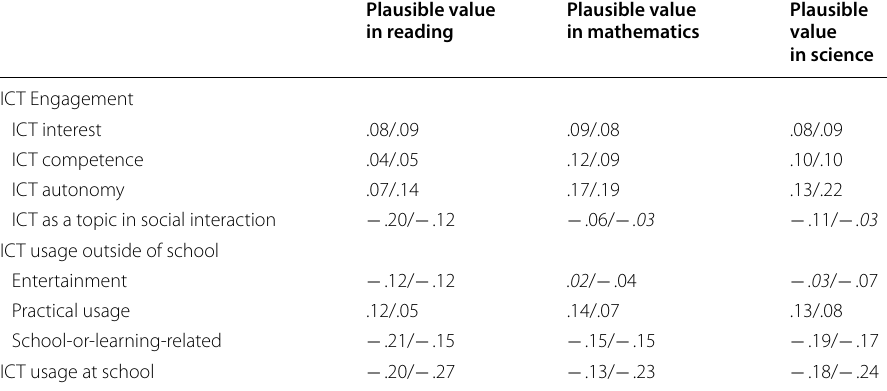
Table 6 Correlations between ICT Engagement scales, ICT Usage, and competencies in PISA for Switzerland and